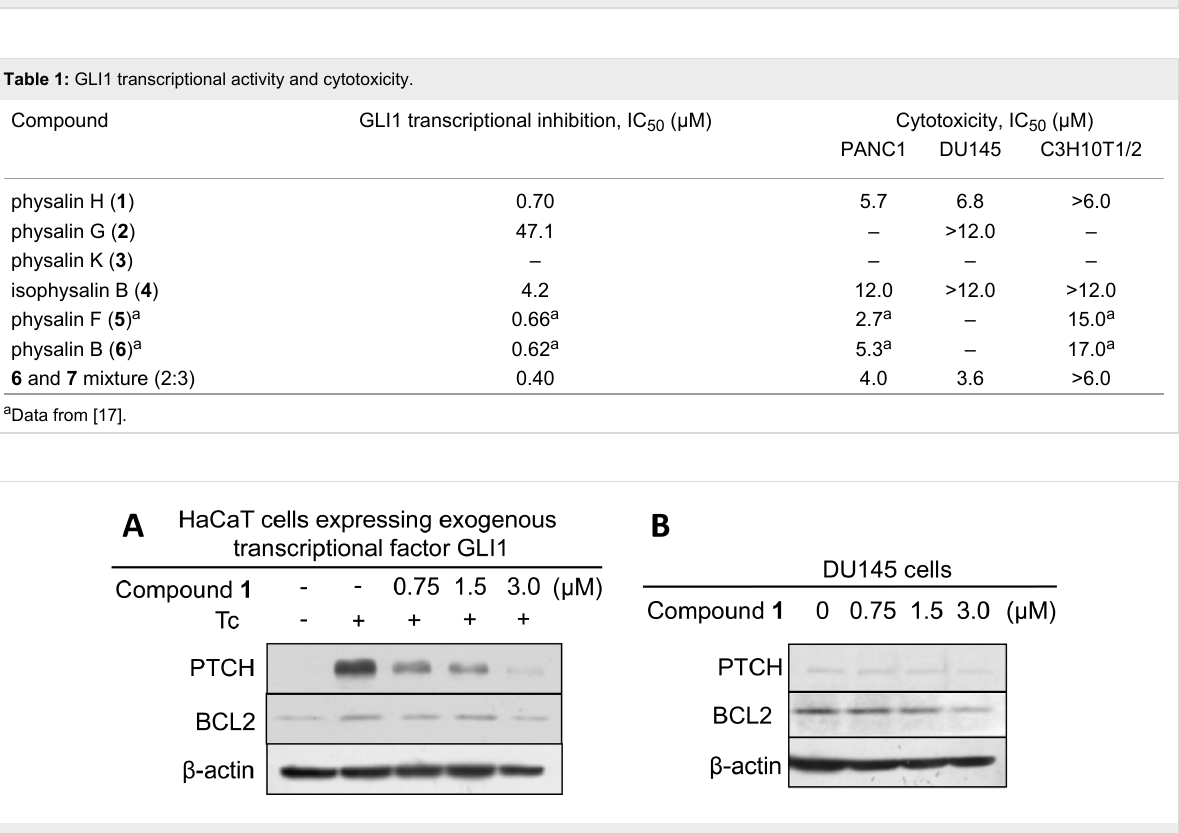
Figure 4: Inhibition of protein expression by compound 1 . (A) Western blot analysis of PTCH, BCL-2 protein levels in GLI1-overexpressing HaCaT cells after treatment with 1 . (B) Western blot analysis of PTCH, BCL-2 protein levels in DU145 cells after treatment with 1